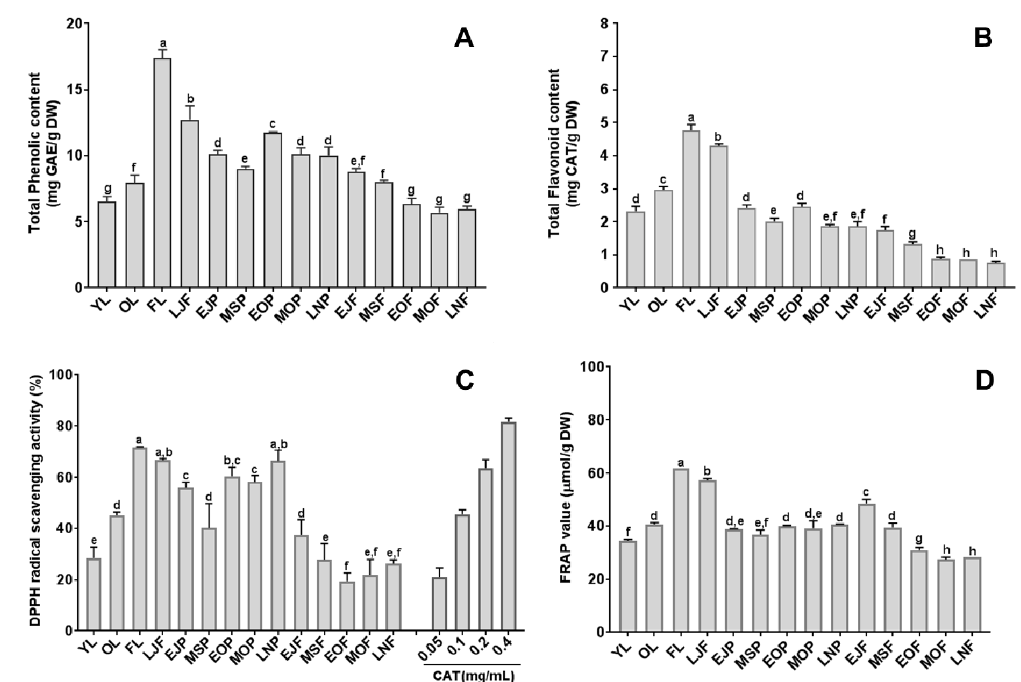
Figure 4. Total phenolic content (TPC), total flavonoid content (TFC), and anti-oxidant activity of tissues and fruit-maturity stages of C. unshiu . ( A ) TPC, ( B ) TFC, ( C ) DPPH radical scavenging activity assay, with catechin (CAT) as a standard, ( D ) ferric reducing anti-oxidant power (FRAP) activity assay. Data are expressed as mean ± SD (n = 3), and different small letters indicate a significant difference by Duncan’s test; p < 0.05.